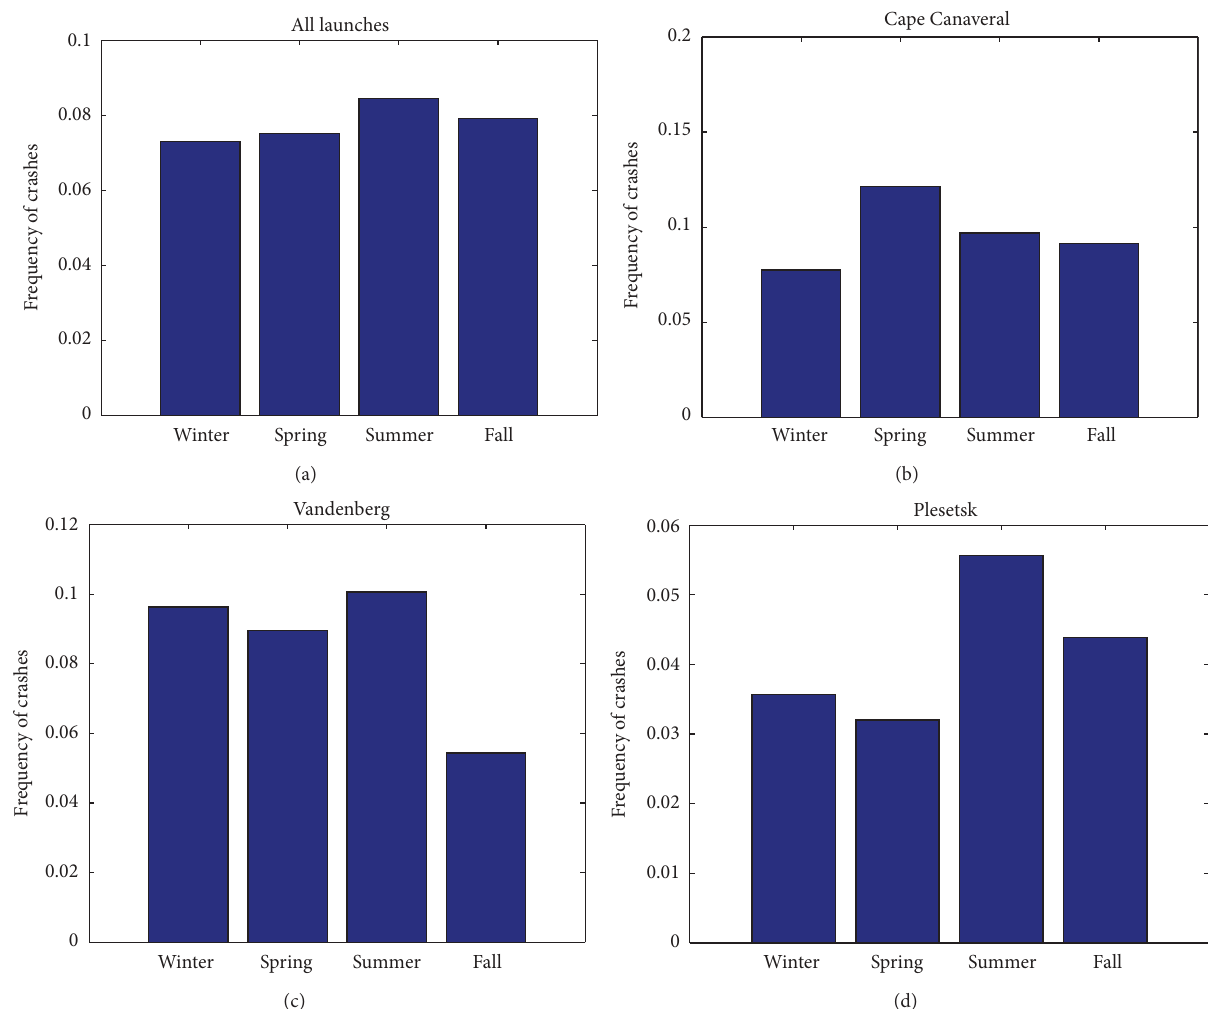
Figure 5: The season distribution of relative launch crashes (the relative number of crashes normalized on a number of launches throughout a certain season): (a) world-wide, (b) Cape Canaveral, (c) Vandenberg, and (d)